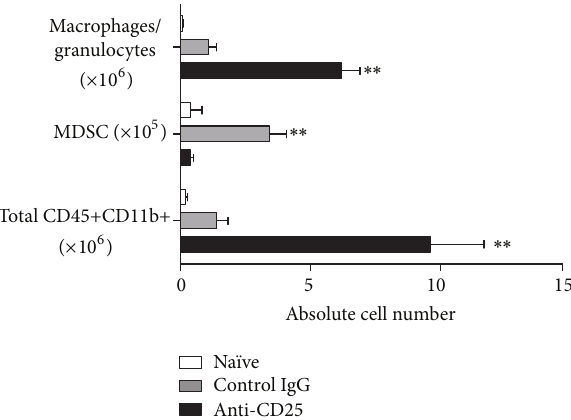
Figure 3: Quantitative analysis of myeloid cell infiltration in the brain of PC61-treated mice. Absolute numbers of brain-infiltrating total CD45+CD11b+ myeloid cells, Gr-1+ MDSC, and F4/80+ granulocytes/macrophages were calculated in PC61 (black bars, 𝑛 = 9 ) and control IgG- (grey bars, 𝑛 = 7 ) treated mice 14 days after tumor challenge. Naive mice were included as controls (white bars, 𝑛 = 3